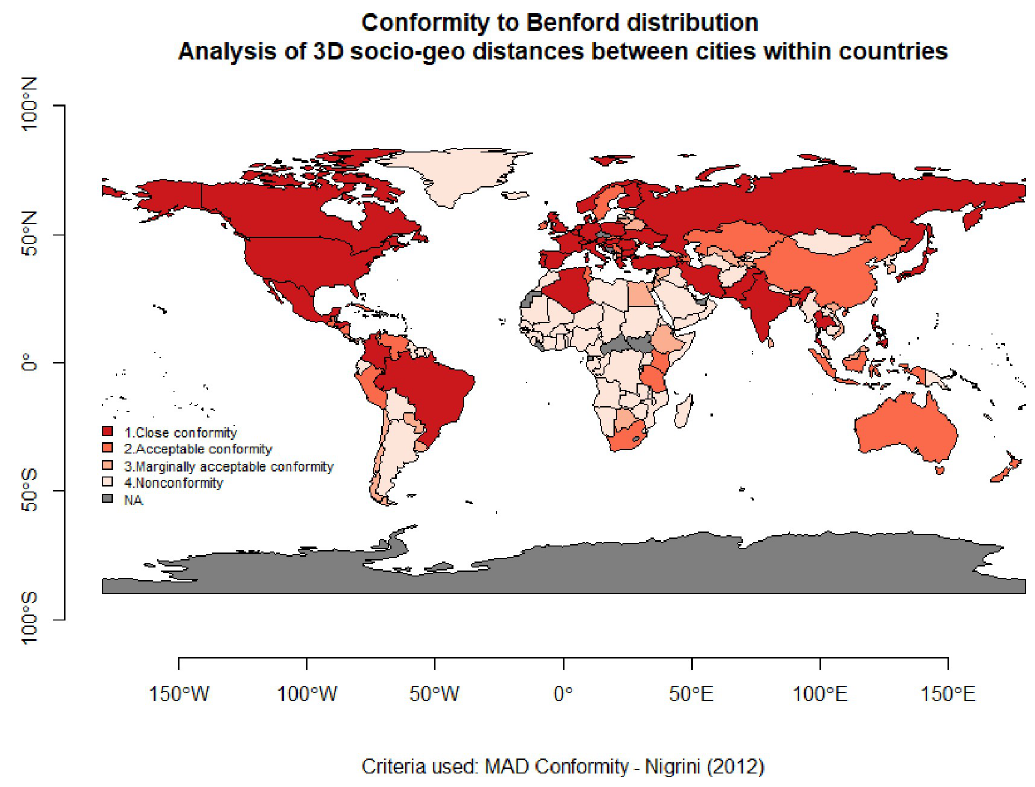
Fig 1. Conformity to Benford distribution—analysis of 3D mutual socio-geographic distances between cities within countries. Source: Own study with the use of benford.analysis::, maps::, rworldmap:: R packages.